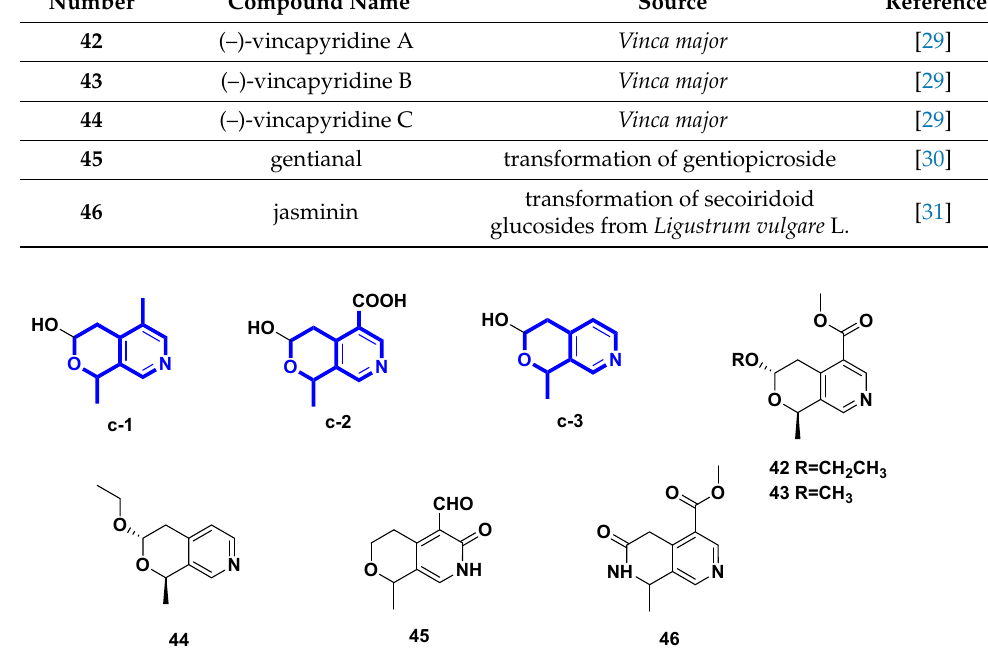
Figure 4. Pyridine alkaloids derived from hemiacetal secoiridoid (Type III). ( − )-Vinmajpyridines A–C ( 42 – 44 ) were isolated from the aerial parts of Vinca major (Apocynaceae) cultivated in Pakistan [29] . Gentianal ( 45 ) was yielded from the biotransfor- mation of gentiopicroside by the asexual mycelia of Cordyceps sinensis [30] . However, jas- minin ( 46 ) was isolated by treating secoiridoid glucosides from fruits of Ligustrum vulgare L. with H 2 SO 4 and subsequently NH 3 .